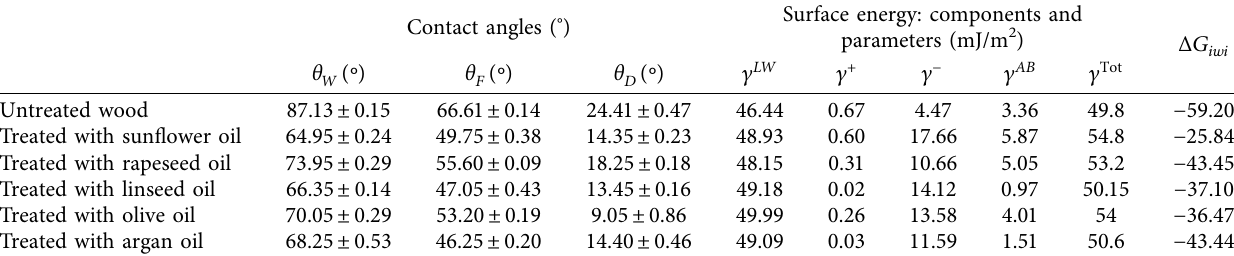
Table 3: Contact angles values, surface energies, and their components of cedar wood before and after treatment.